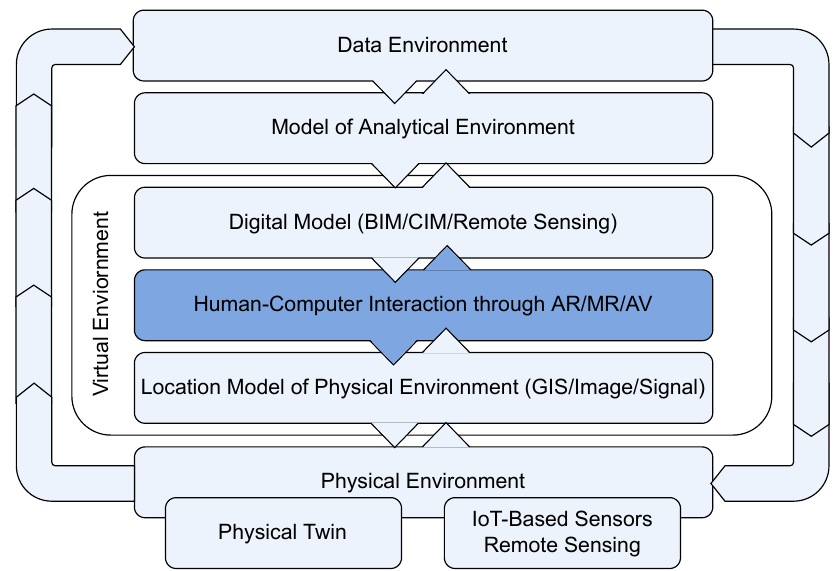
Figure 16. Fused Twins Torus Stack . Generalised technology stack for the FTs paradigm based on [17]. The stack implements a full DT and expands the Virtual Environment to accommodate the FTs. Data flow is shown through the arrows. The stack becomes a torus because the chain of technologies and environments requires circular links of the data. Changes to a DT in the Virtual Environment flow back to the PT through the Data Environment. Generated with